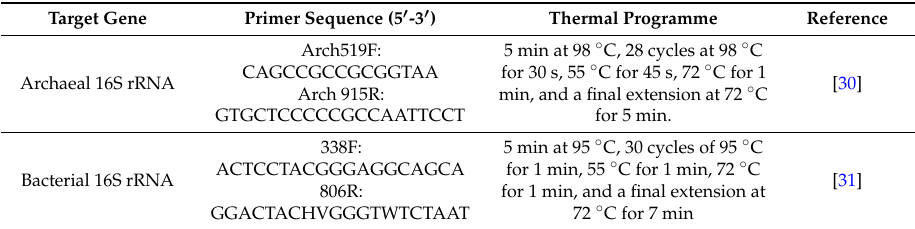
Table 2. PCR primers and amplification